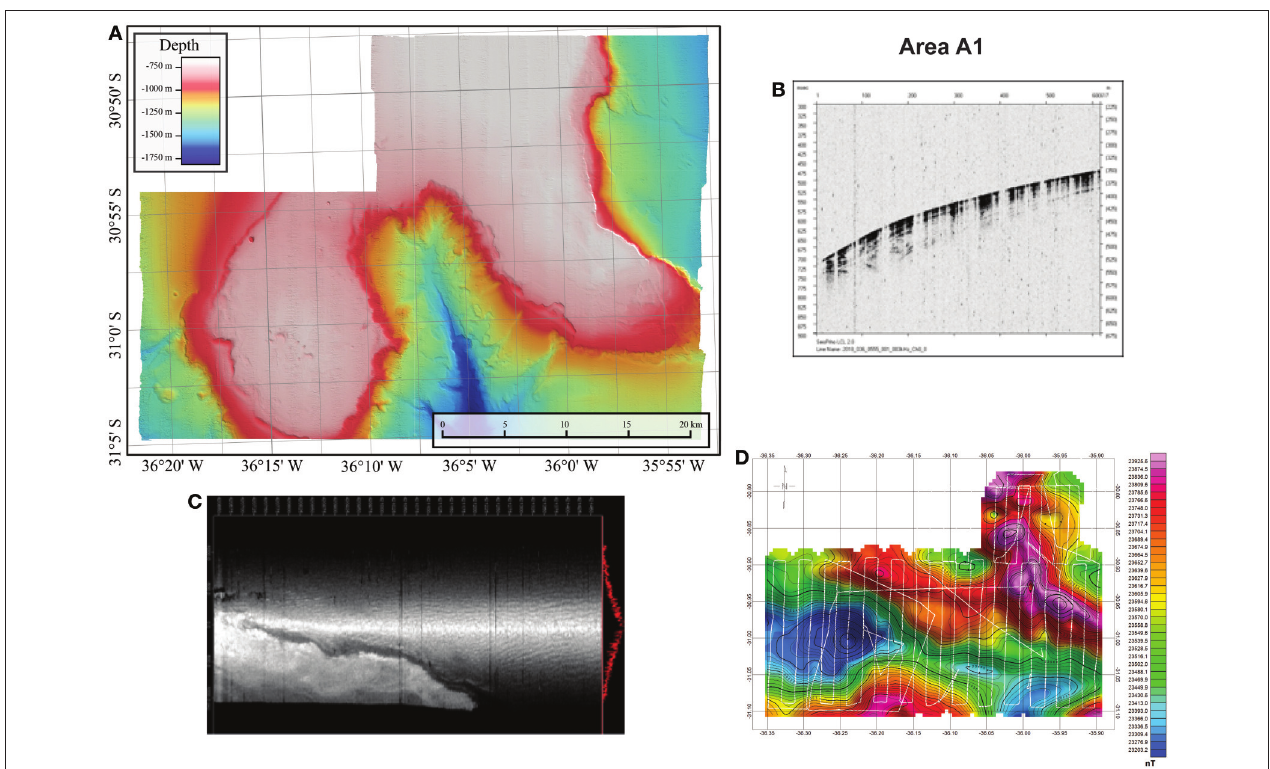
FIGURE 3 | Geophysical survey acquired at Rio Grande Rise: (A) Multibeam bathymetry map, (B) example of a chirp record, (C) example of multibeam backscatter record and (D) total magnetic field (observed raw data with spike removed) from area A1.